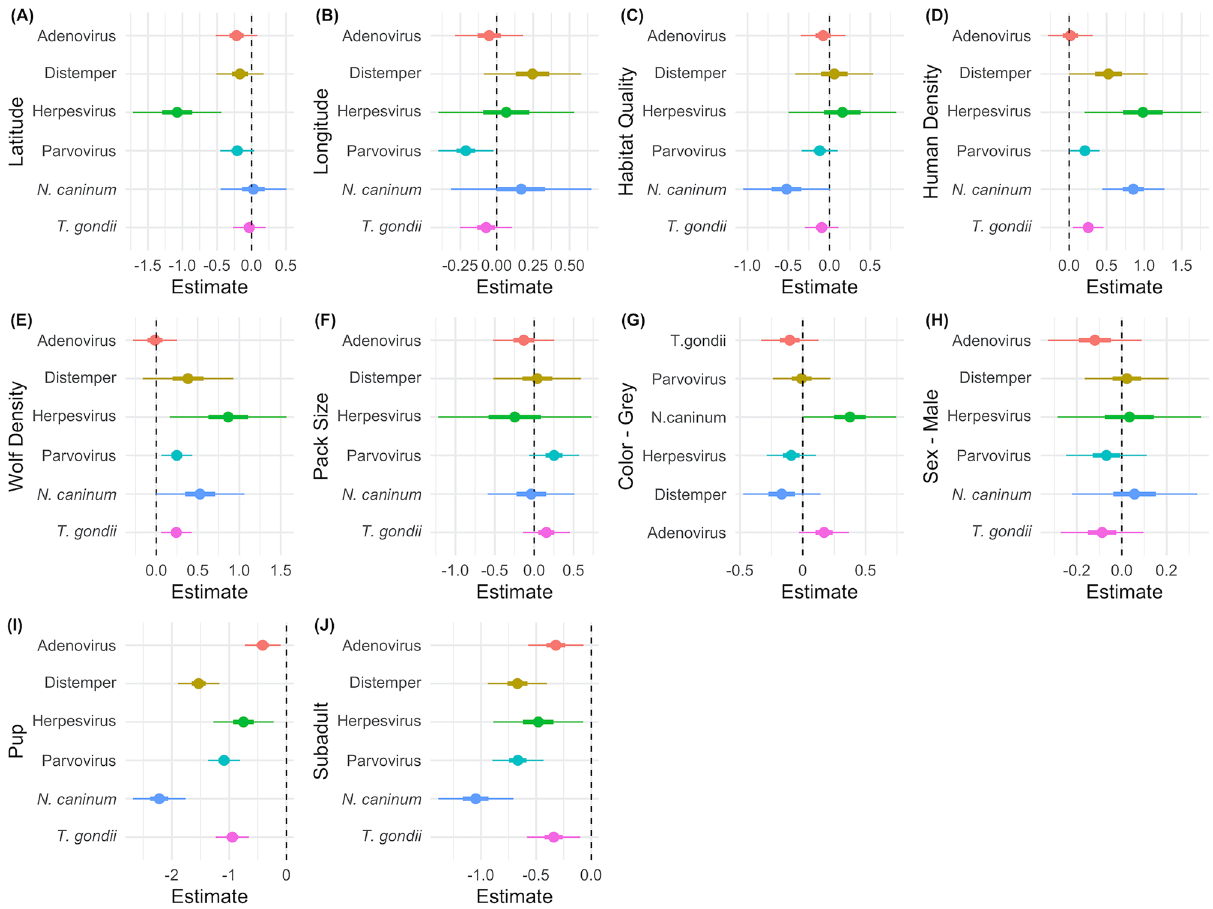
Figure 4. Coefficient estimates (log-odds) of the fixed effects in the ( A , B ) geographic and ( C – J ) complete models by pathogen (colors) 39 . Thick and thin lines are 50% and 95% confidence intervals, respectively. Categorical variables are interpreted as the effect of: ( G ) gray wolves with respect to black, ( H ) males with respect to females, and ( I ) pups and ( J ) subadults with respect to adults.